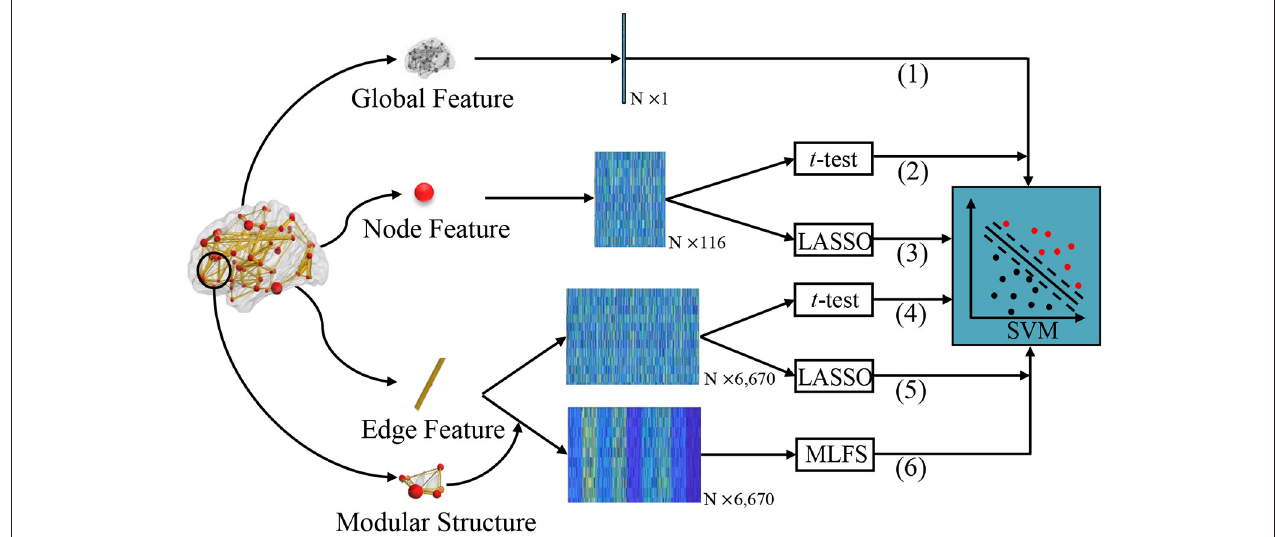
FIGURE 4 | Different schemes for comparison. (1) The Global method extracts global clustering coefficients from FBNs as a one-dimensional vector. We extract local clustering coefficients from 116 nodes as a 116-dimensional matrix and perform feature selection via (2) t -test (called Note- t -test) and (3) LASSO (called Node-LASSO). We extract 116 × 115 / 2 network edge weights from 116 nodes as a 6,670-dimensional matrix, and perform feature selection via (4) t -test (called Edge- t -test) and (5) LASSO (called Edge-LASSO); (6) The proposed MLFS scheme for modularity-guided feature selection. For the fair comparison, the same SVM classifier is used for these six methods for